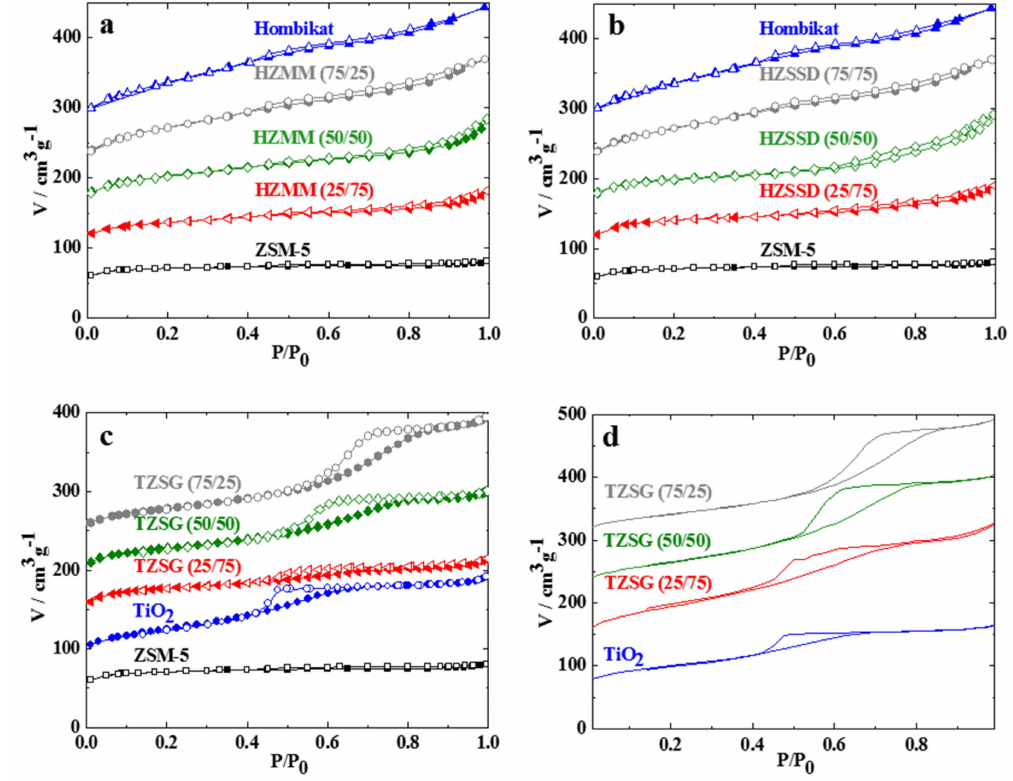
Figure 2. N 2 sorption isotherms of ( a ) Hombikat, composites from mechanical mixture (HZMM) and zeolite ZSM-5; ( b ) Hombikat, composites from solid-state dispersion (HZSSD) and zeolite ZSM-5; ( c ) composites from sol-gel synthesis (TZSG) and TiO 2 ; ( d ) calculated isotherms for the TiO 2 fraction of the TZSG composites. For clarity, all isotherms in parts a to c were vertically displaced by 60 cm 3 ¨ g ´ 1 except for the isotherms in part d, which were displaced by 80 cm 3 ¨ g ´ 1